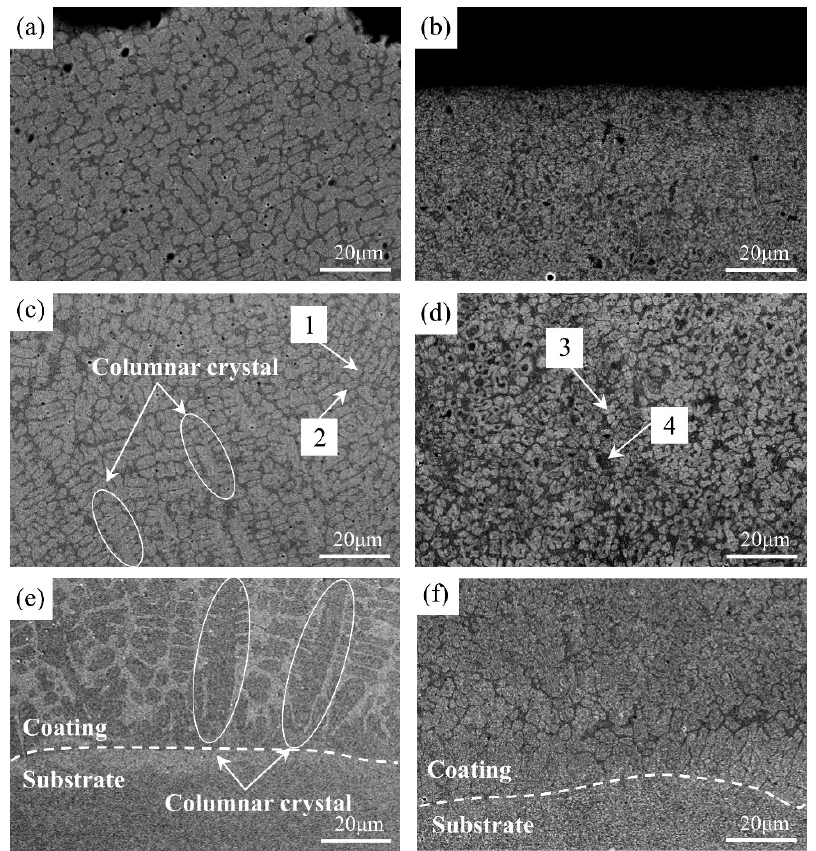
Figure 6. Microstructure of coating: ( a ) top of the GF coating; ( b ) top of the HF coating; ( c ) middle of the GF coating; ( d ) middle of the HF coating; ( e ) bottom of the GF coating; ( f ) bottom of the HF coating.